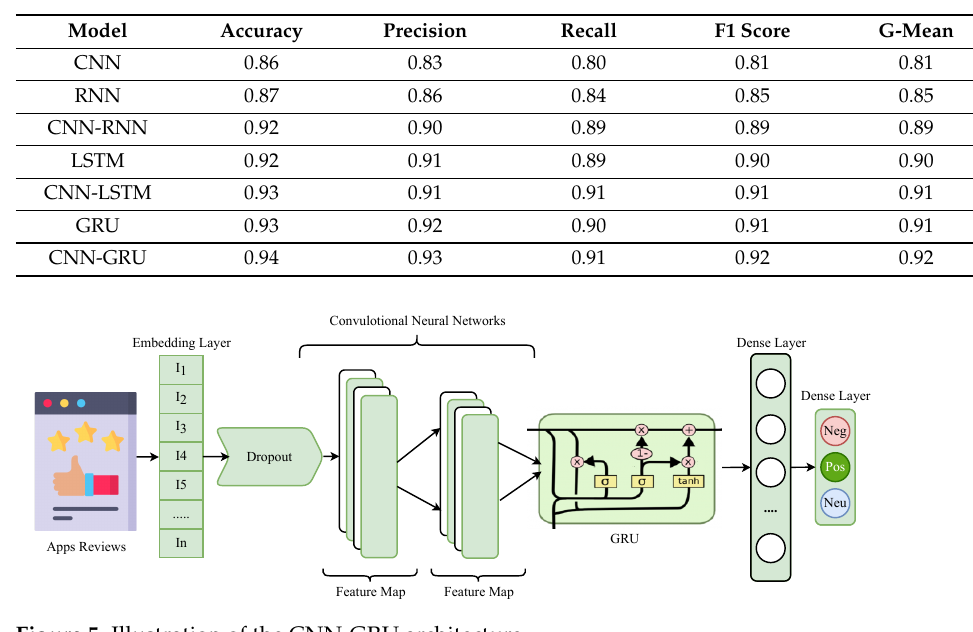
Figure 4. Architecture of deep-learning models. Table 16. Deep-learning model results.